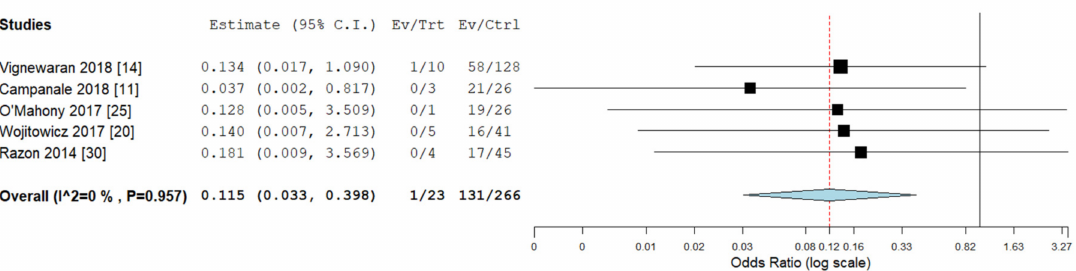
Figure 9. Pooled odd ratio (OR) for 22q11 microdeletion in right aortic arch with concomitant right ductal arch and right aortic arch with concomitant left ductal arch. (black vertical line: OR = 1, red dashed line = estimated pooled OR in the present analysis). Iˆ2: I 2 of Higgins.